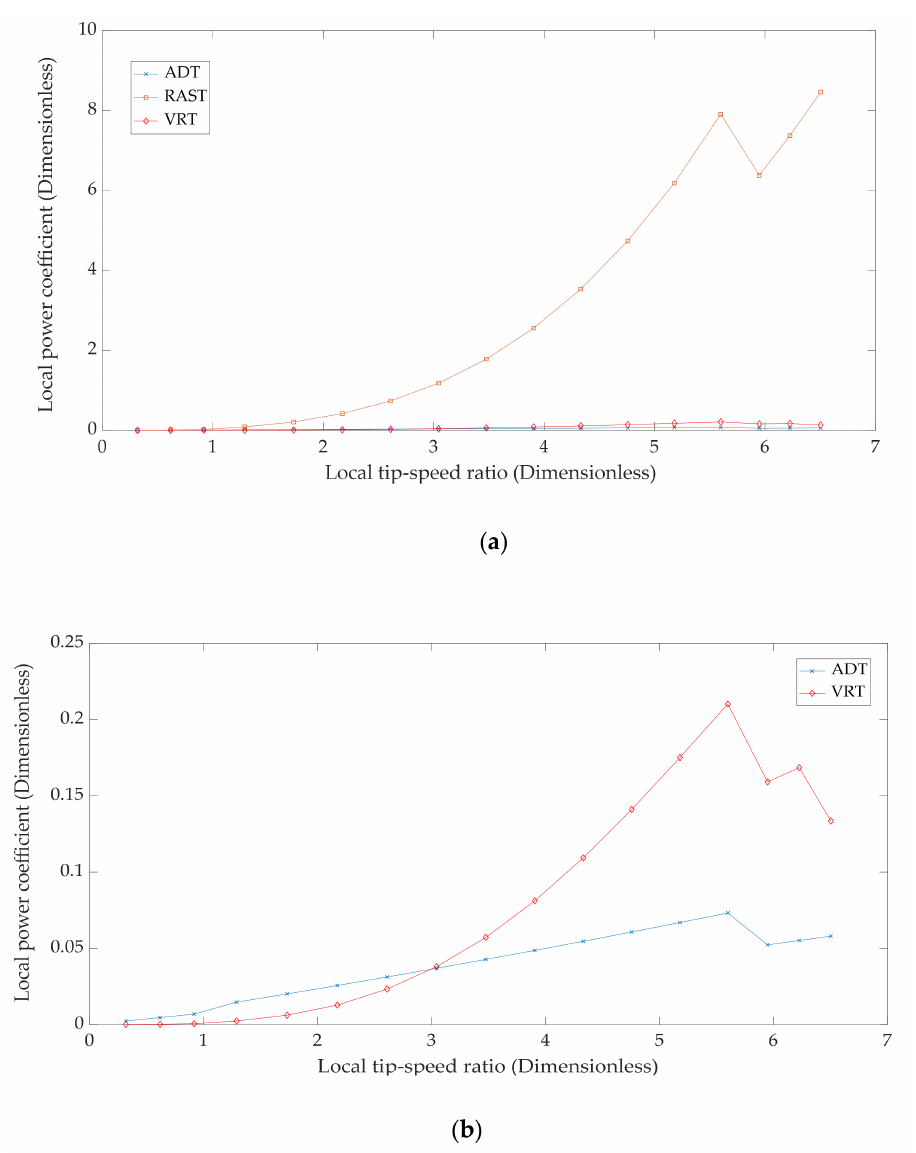
Figure 7. Local power coefficient as a function of the local tip-speed ratio: ( a ) plots of the ADT, the RAST and the VRT; and ( b ) those of the ADT and the